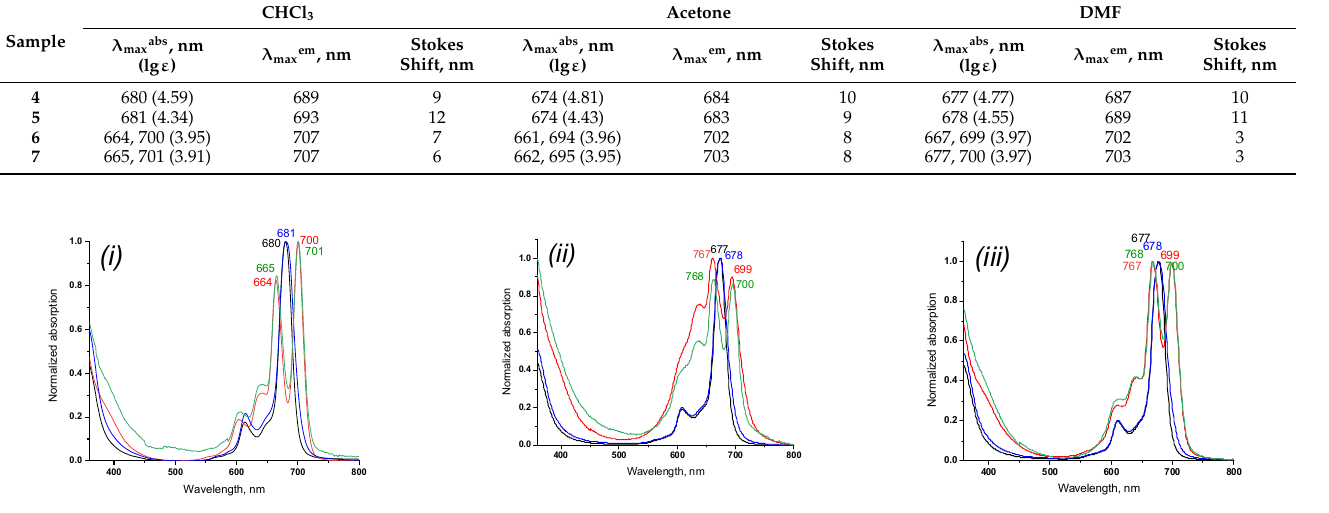
Figure 1. Normalized UV-vis spectra of complexes 4 (black curve), 5 (blue curve), 6 (red curve), and 7 (green curve) in CHCl 3 ( i ), acetone ( ii ), and DMF ( iii ).